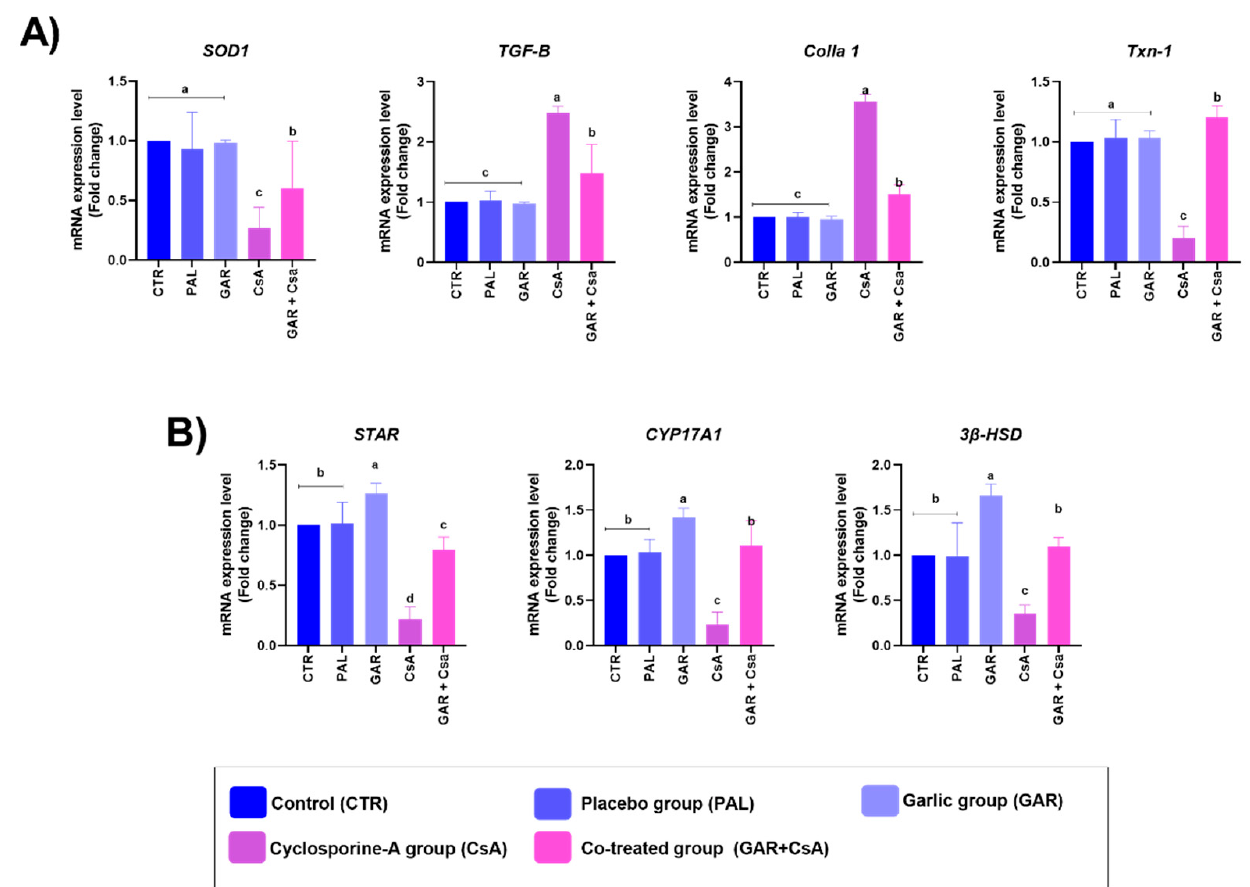
Figure 2. ( A ). Illustration of real-time quantitative PCR analysis of SOD 1 , TGF- β 1, Colla1, and Txn1 gene expression in rat’s liver following Cyclosporine (CsA) and/or Garlic. ( B ). Illustration of real-time quantitative PCR analysis of STAR, CYP17A, and 3 β -HSD gene expression in rat testes following administration of Cyclosporine (CsA) and/or Garlic. Data is expressed as mean ± SEM of 8 observations. Columns carrying different superscript letters are significantly different at p ≤ 0.05 compared to the control group for each gene expression.